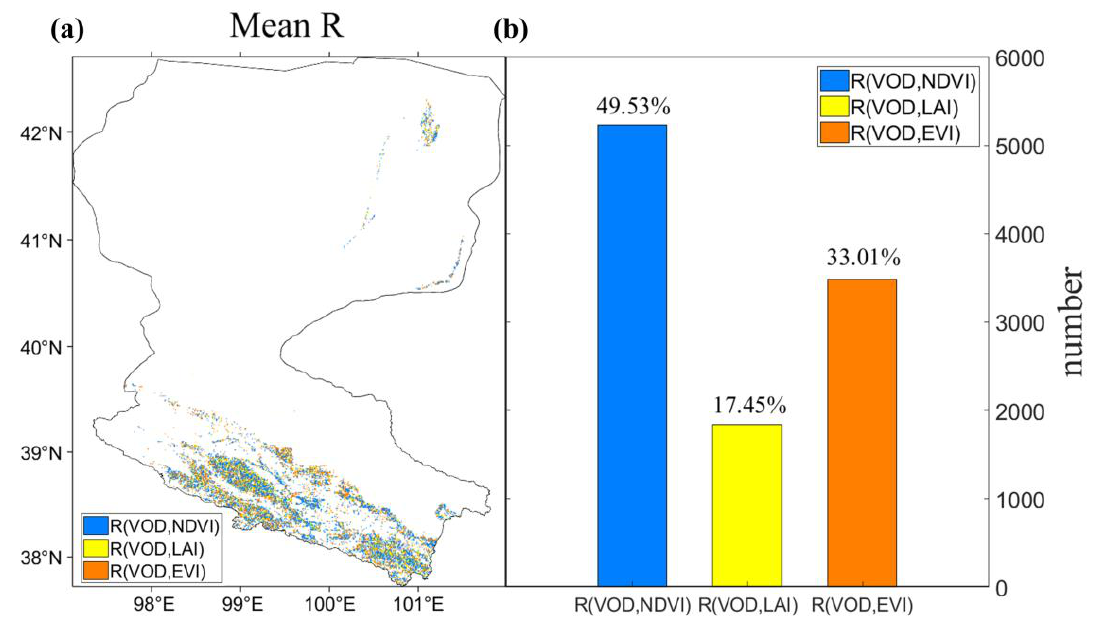
Figure 11. Map showing the highest absolute temporal correlation (R) values between MODIS VIs and VOD ( a ) and the percentage of pixels over the study regions ( b ).